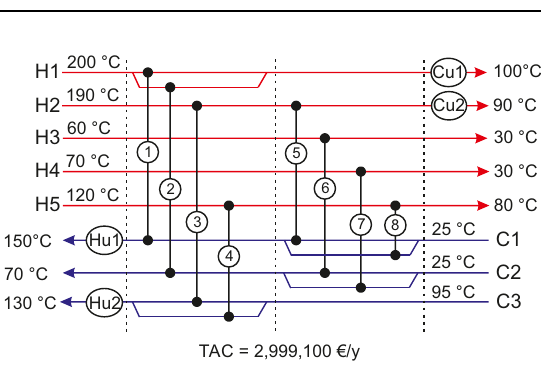
Figure 2. HEN obtained without HP and ST options case